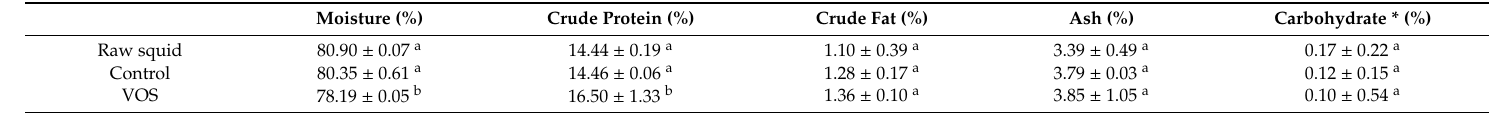
Table 7. Proximate composition of neritic